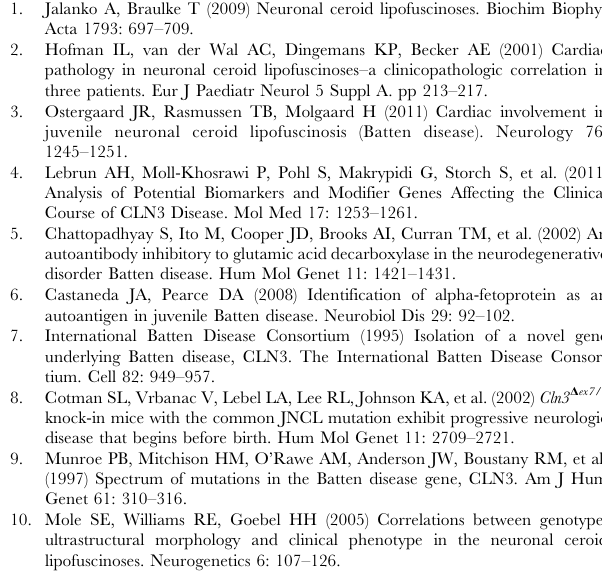
Table S3 Echocardiography analysis of Cln3 D ex7/8 mice. Cardiovascular function parameters of wild-type ( Cln3 + / + ), het- erozygous ( Cln3 + / D ex7/8 ), and homozygous ( Cln3 D ex7/8/ D ex7/8 ) littermate mice, measured by echocardiography, are shown. LVID = left ventricular internal dimension, mm= millimeters, bpm = beats per minute, ml=milliliters, % =percent. Values represent the mean 6 SEM. No genotypic differences in echocardiography parameters were observed. 6–8 mice per group (genotype/sex) were analyzed, as indicated. Table S4 Blood analytes and hematological parameters in Cln3 D ex7/8 mice. The results of clinical chemistry and hematological analysis of blood isolated from 12- to 19-week-old wild-type ( Cln3 + / + ), heterozygous ( Cln3 + / D ex7/8 ), and homozygous ( Cln3 D ex7/8/ D ex7/8 ) littermate mice are shown, with significantly different values indicated in bold. Each row of values represents an independent set of measurements. Data represent mean 6